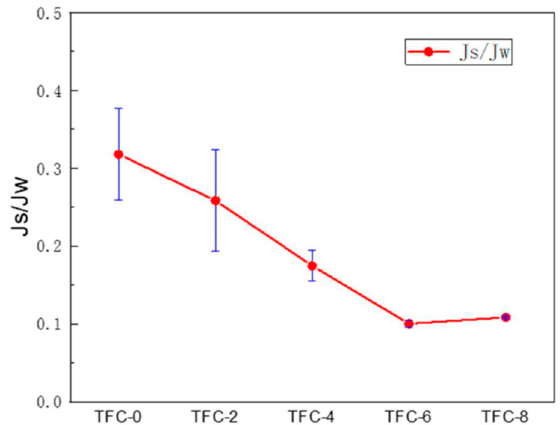
Figure 8. Js/Jw of MPD/TMC composite FO membranes with different concentrations of NaHCO 3 in the aqueous phase.